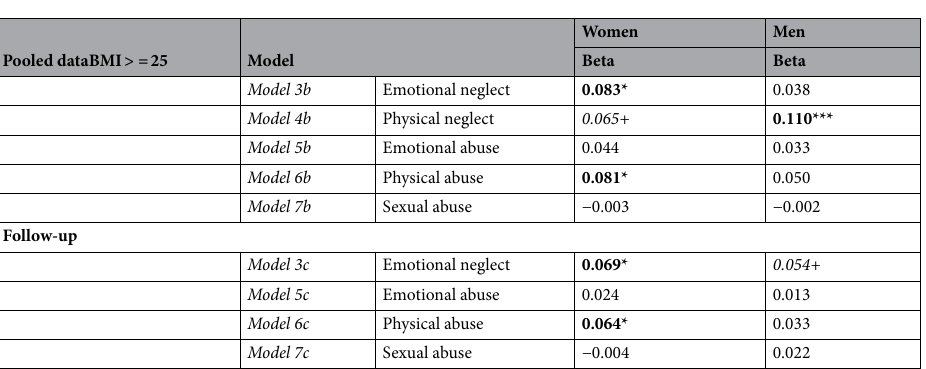
Table 5. Results of the multivariable regression models of the sensitivity analysis—baseline. At BMI > = 25, the effect of childhood trauma categories was more stable in men than in women. Physical neglect remained the main predictor for an increased WHtR in men, in women, emotional neglect remained the strongest predictor for an increased WHtR, however, compared to the main analysis, physical abuse became a significant predictor as well. + p < = 0.1, *p < = 0.05, **p < = 0.01, ***p < = 0.001. Statistical significant results are highlighted in bold.